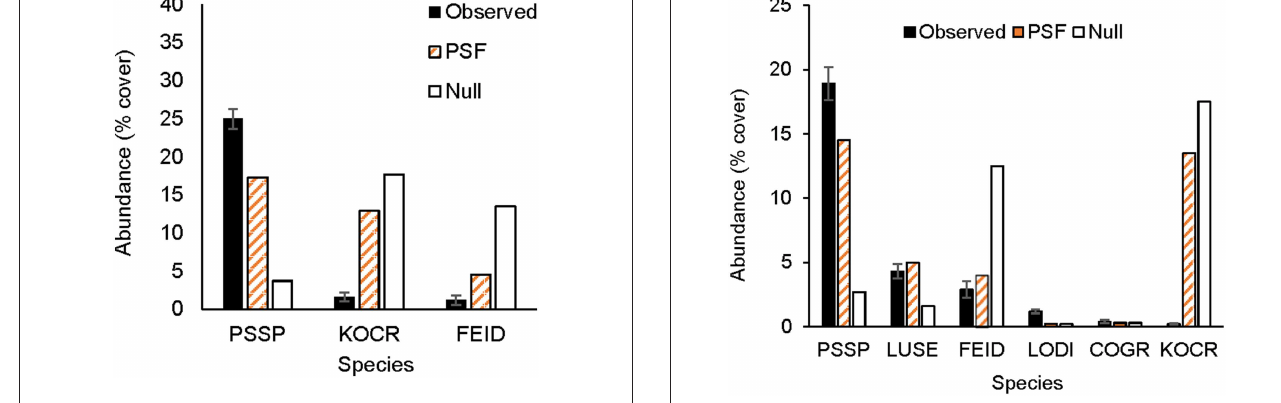
FIGURE 2 | Observed and predicted abundance of native plant species in a FIGURE 3 | Observed and predicted native plant abundance. Observed plant three-species experimental plant community grown for 3 years (2011–2013). abundance was recorded in 25 ex-arable fields over 13 years (Kulmatiski and Model predictions were made either with plant-soil feedback effects (PSF) or Beard, 2019). Model simulations of plant community growth for these six without plant-soil feedback effects (Null). Species codes listed in the Figure 1 . common native species were performed for a 10-year period either with plant-soil feedback data (PSF; i.e., with information on plant growth rates on different soil treatments) or with a null model (Null) which was parameterized only with plant growth rates on control soils. PSSP, Pseudoroegneria spicata ; experimental communities ( F (1,10) 32.6, P < 0.001, R 2 0.77) LODI, Lomatium dissectum ; LUSE, Lupinus sericeus ; COGR, = = but Null model predictions were not ( F (1,10) 0.17, P 0.686). = =